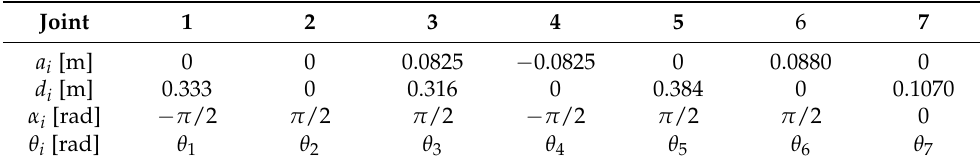
Table 1. Denavit-Hartenberg (DH) for Emika Franka Panda manipulator.